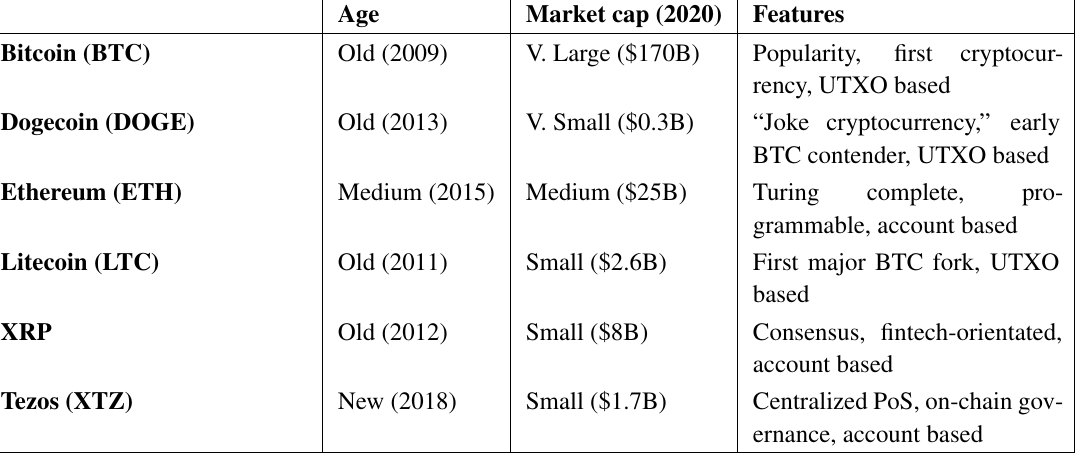
Table 1. List of studied cryptocurrencies, chosen to cover different